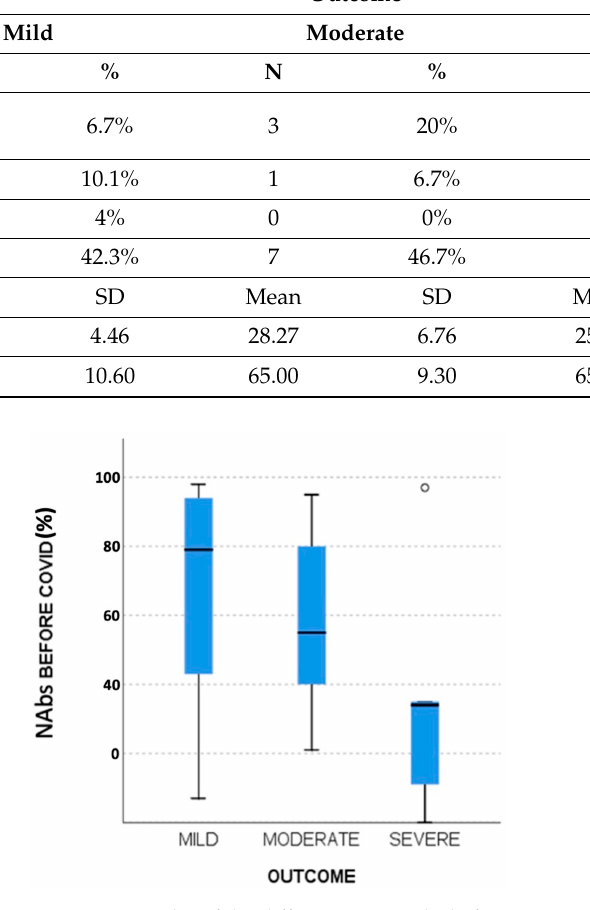
Table 7. Differences in COVID-19 outcomes depending on performance status, response to treat- ment for MM, and NAbs before SARS-CoV-2 infection (SD: stable disease, PR: partial response,